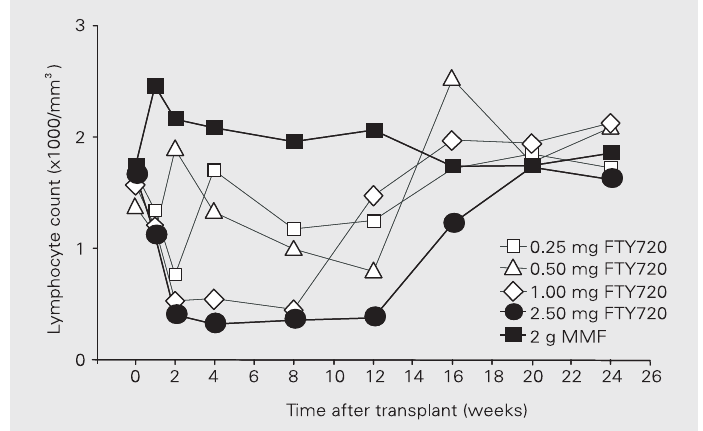
Figure 4. Time course of FTY720-induced lymphopenia during the 12-week treatment phase and return to baseline values upon drug discontinuation. MMF = mofetil myco- phenolate. Table 3. Mean peripheral blood lymphocyte counts and percent lymphocyte reduction between weeks 4 and 12 in the 5 groups of